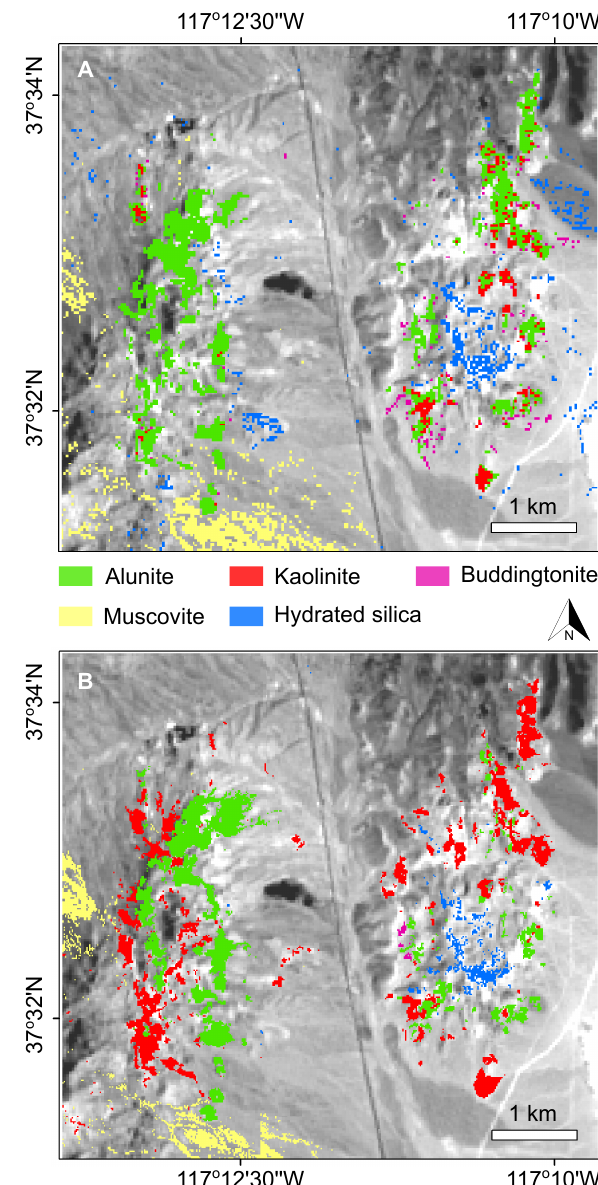
Figure 5: Examples of linear regression between the original Hy- perion data and the pseudo-hyperspectral data at Bands 157 and 185